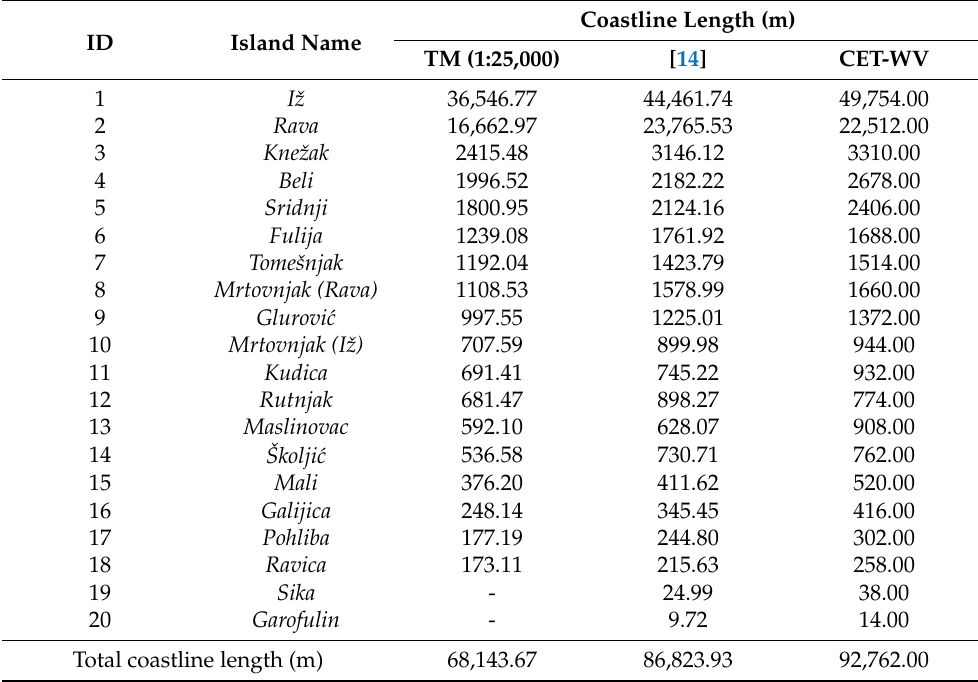
Table 4. Extracted coastline lengths (m) of the Iž-Rava island